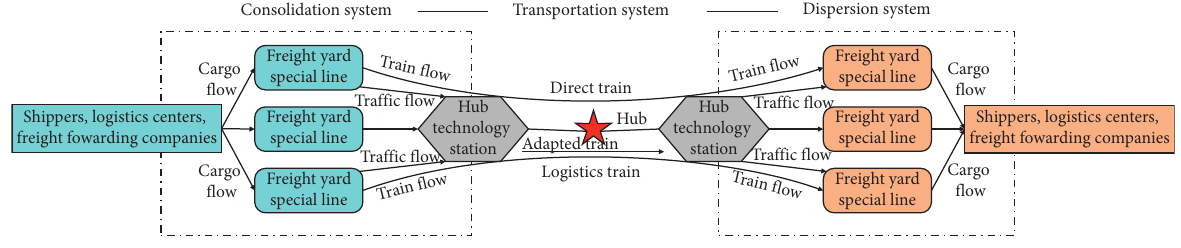
Figure 1: Schematic diagram of the railway collection and distribution system.